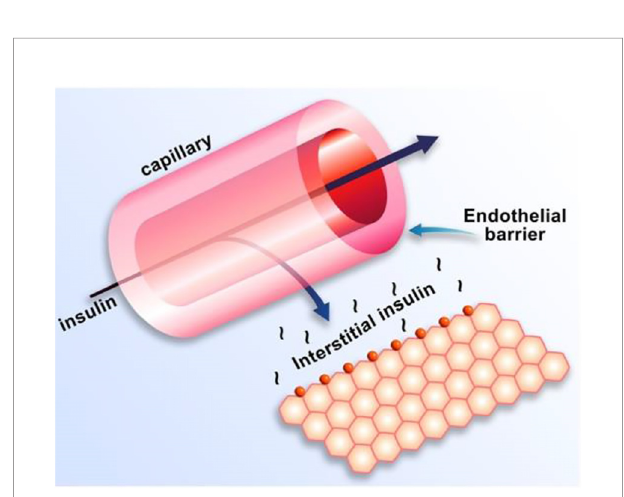
FIGURE 9 | Schematic of insulin transport from blood to interstitial fl